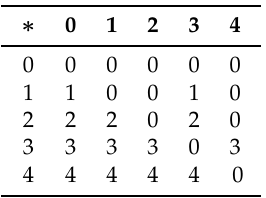
Table 3. Cayley table of the operation ∗ .